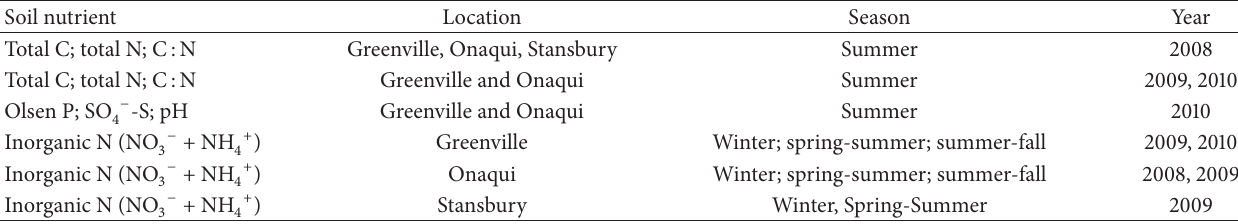
Table 1: Soil-sampling schedule for soil nutrients.